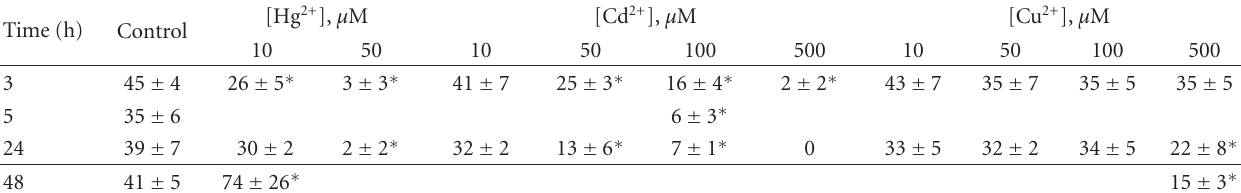
Table 1: Basal respiration rates (%) of PC12 cells after di ff erent time of incubation with increasing concentration of Hg 2+ , Cd 2+ , or Cu 2+ . Time (h)